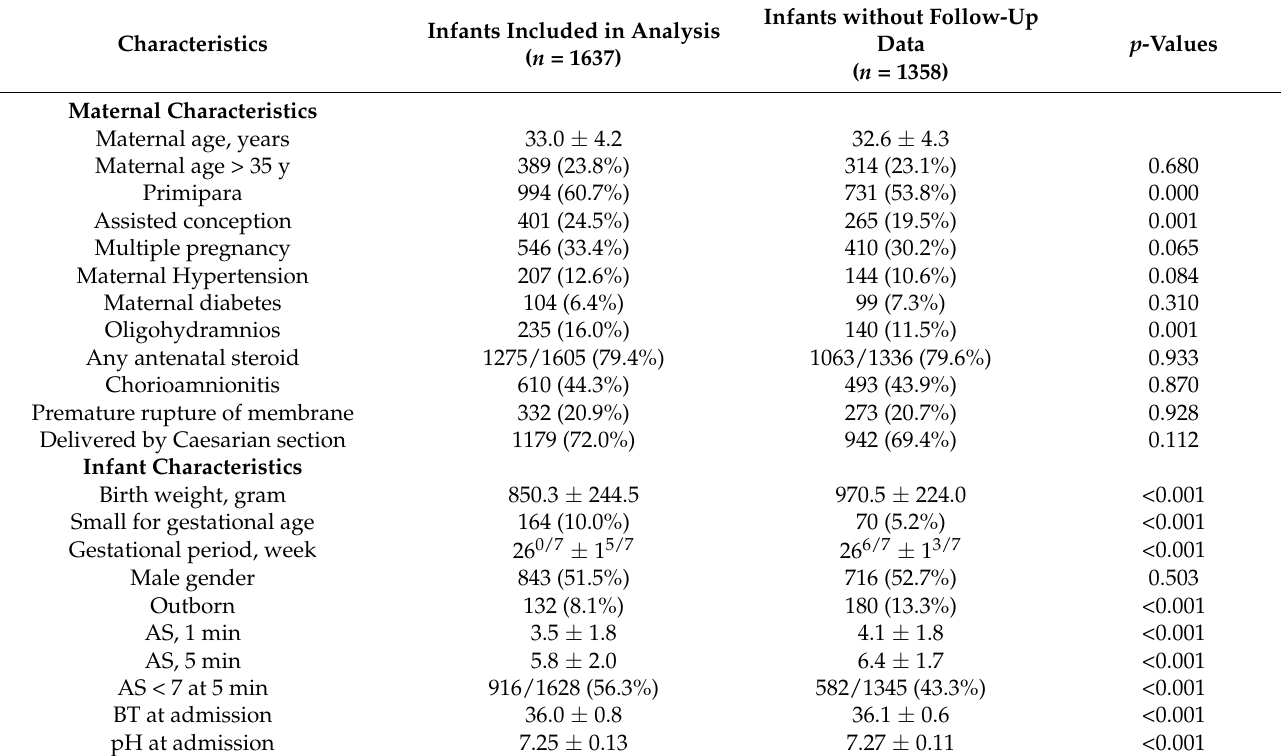
Table 4. Baseline characteristics of infants who were not evaluated at 18–24 months of corrected